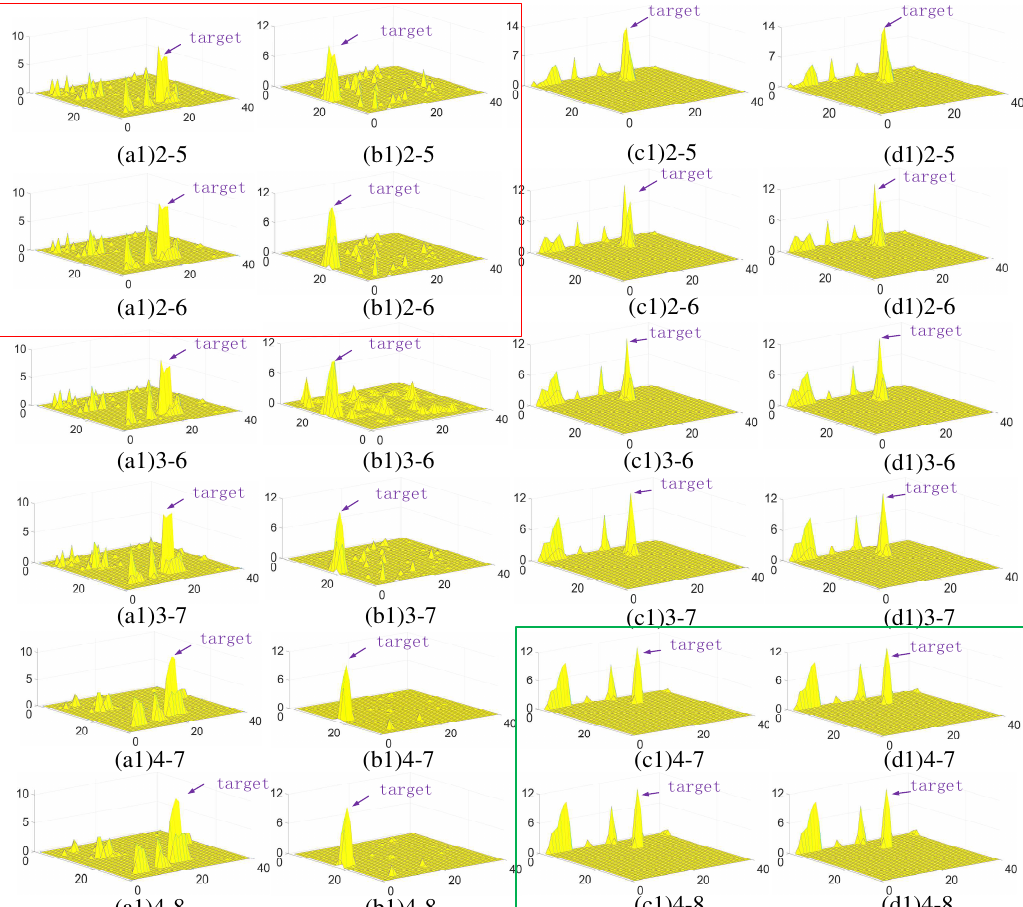
Figure 10. Multi-scale “center-surround difference” analysis results.